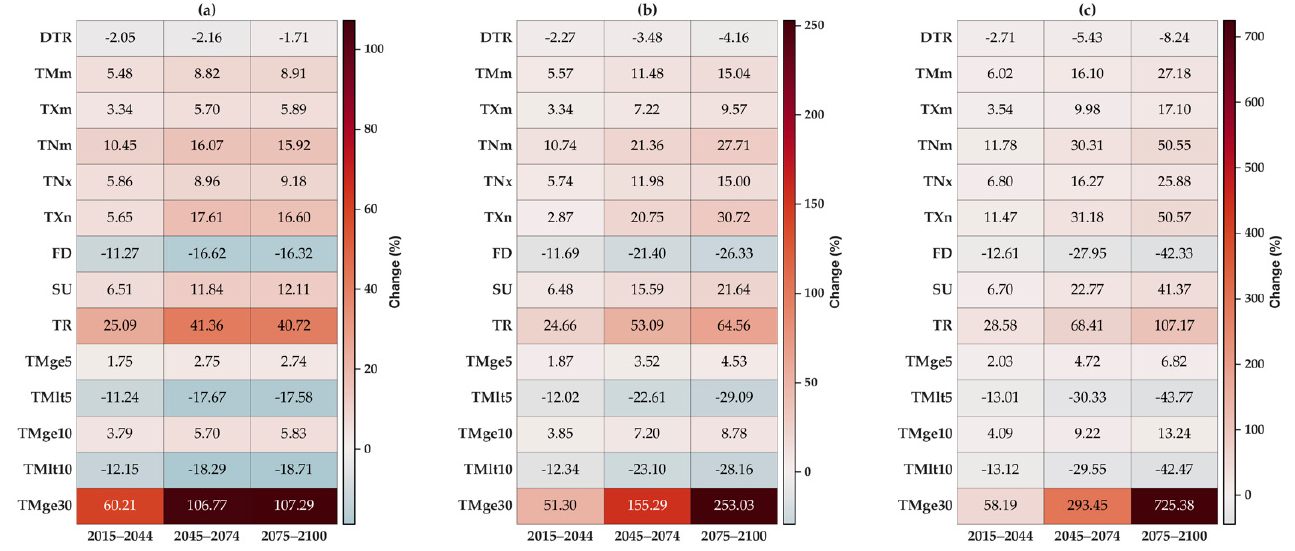
Figure 5. Projected changes in temperature extremes under ( a ) SSP1-2.6 ( b ) SSP2-4.5 and ( c ) SSP5-8.5 in three different future scenarios over GRB.